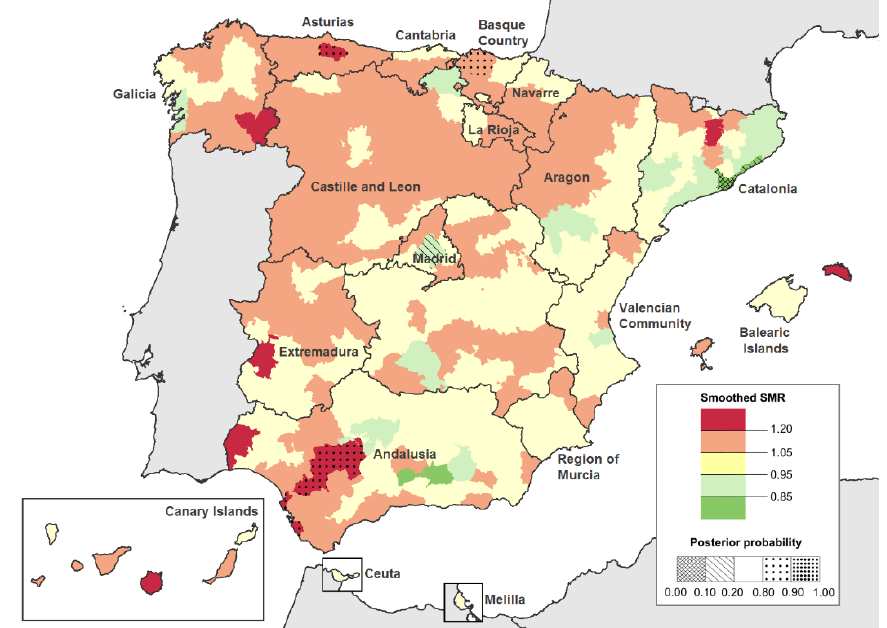
Figure 4. GPA Smoothed-SMR and Posterior probability (PP) by district in Spain (1999–2016, both genders). PP shows those districts with significantly higher (PP > 0.80) and lower (PP < 0.20) risk of death due to GPA than expected for Spain as a whole.